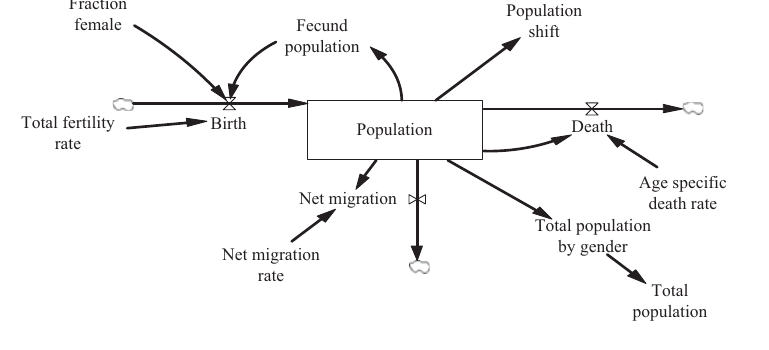
Figure 1. Population sector